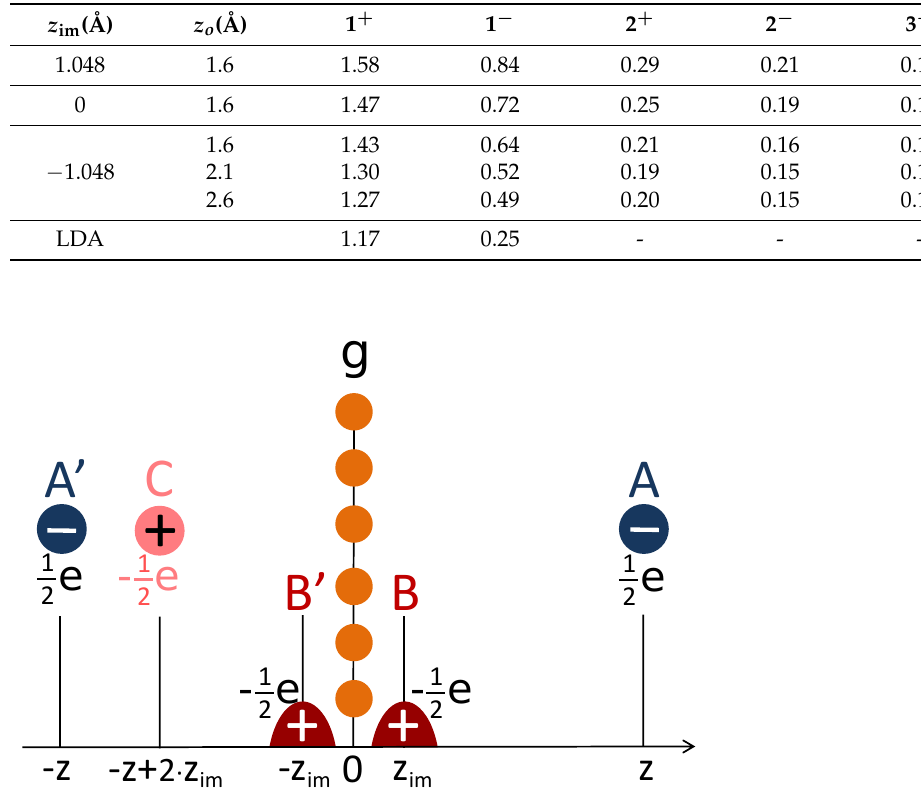
Figure 6. Schematic illustration of the charges created in the vicinity of a graphene monolayer. The carbon atom plane is located at z = 0. The charge distribution in an image-potential state with the centers of gravity on the positive and negative sides according to the graphene plane located at z and − z are represented by two point charges as shown by blue circles A and A (cid:48) . The positive charge density generated in graphene in response to this external perturbation is represented by red areas B and B (cid:48) centered at z im and − z im , respectively. As a result, the negative point charge A interacts with its own image charge C, negative charge A (cid:48) , and positive charge B (cid:48)